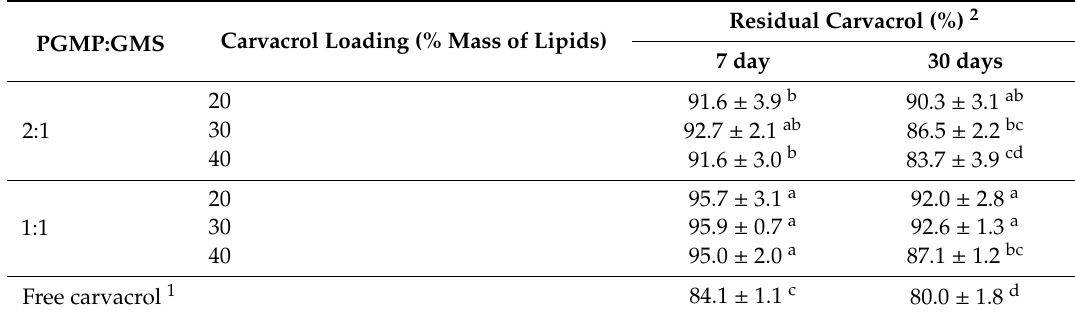
Table 3. Chemical stability of free carvacrol and carvacrol loaded in